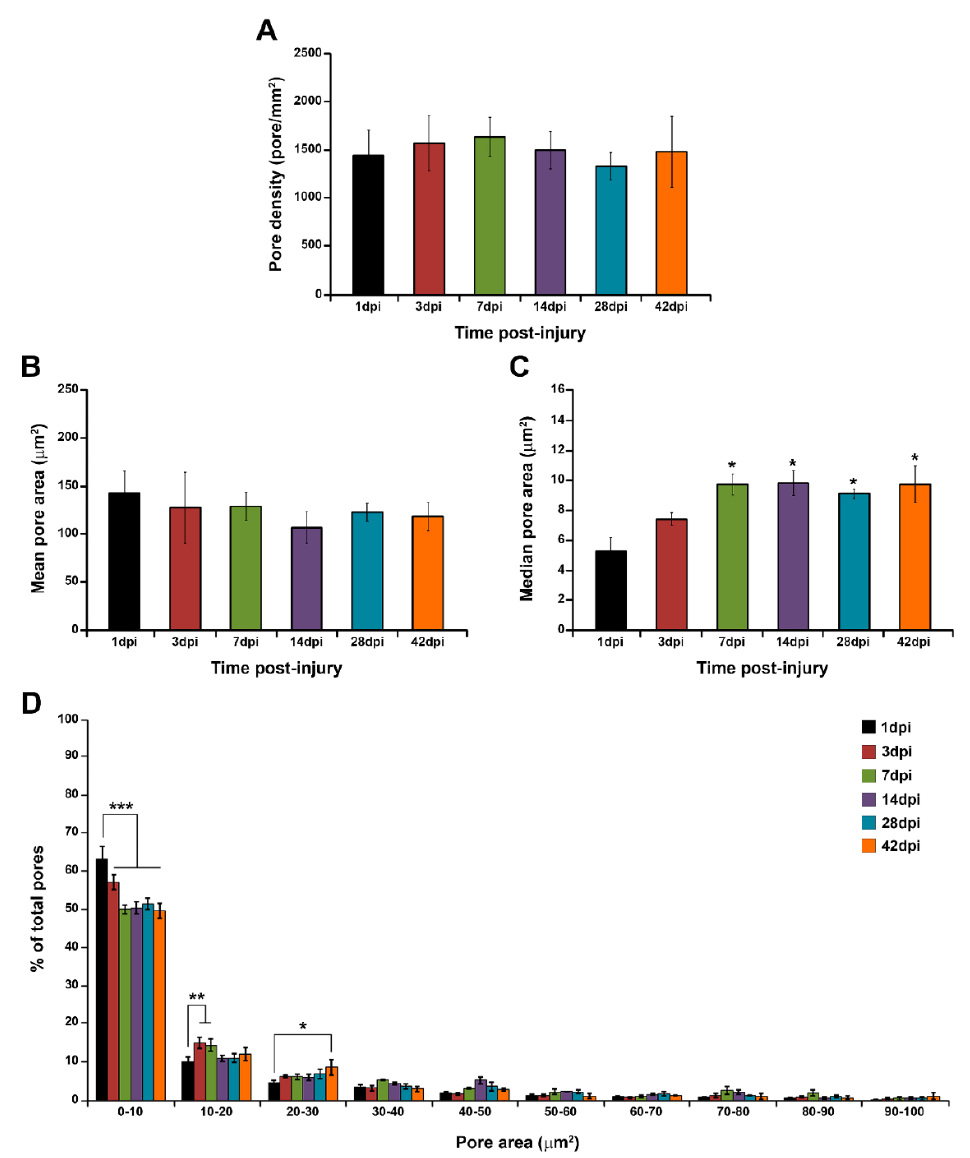
Figure 14. Quantitative analysis of (EIS) 2 -RGD6 porosity. Graphs show data obtained from the quantification of biotinylated (EIS) 2 -RGD6 porosity [experiment (EIS) 2 -RGD6 II] at 1, 3, 7, 14, 28, and 42 days post-injury (dpi) in the (EIS) 2 -RGD6 porous scaffold in the lesion epicentre: ( A ) data from the quantification of the temporal evolution of pore density; ( B ) data obtained from the quantification of the temporal evolution of the mean pore area; ( C ) data obtained from the quantification of the temporal evolution of the median pore area; and ( D ) data obtained from the quantification of the temporal evolution of pore size distribution (*, p < 0.05; **, p < 0.01; and ***, p < 0.001). In ( A – C ), the potential existence of statistically significant between-group differences was assessed by one-way ANOVA followed by the Bonferroni post-hoc test while, for ( D ), two-way ANOVA followed by the Bonferroni post-hoc test was conducted.